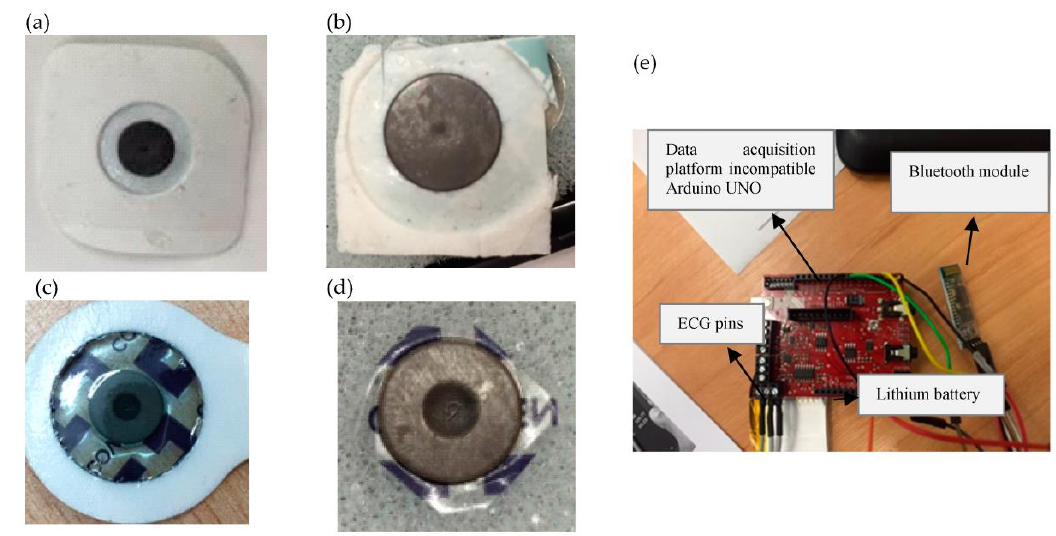
Figure 4. Experimentally used electrodes and data acquisition system. Bigger size of electrode (Ambu) before GN coating in ( a ), and after GN coating in ( b ); smaller size of electrode (Covidien) before GN coating in ( c ), and after GN coating in ( d ); data acquisition unit in ( e ).